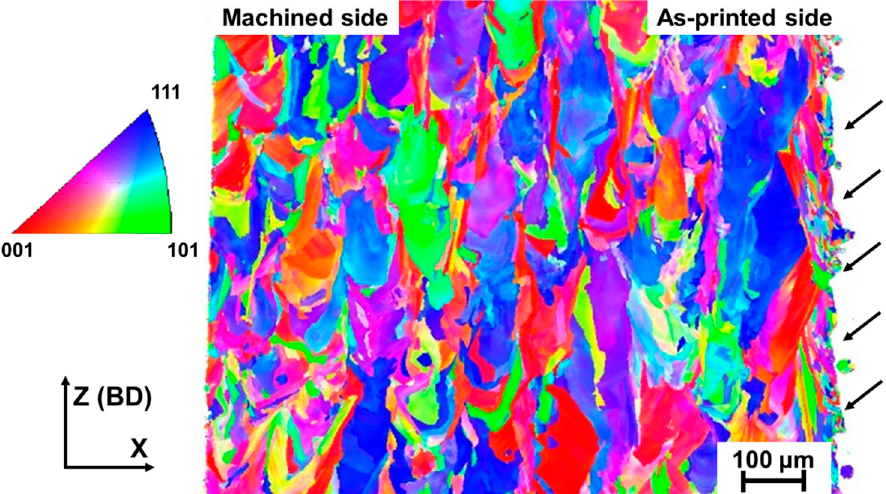
Figure 9. EBSD maps of similar sample as Figure 7 where a randomized texture is formed on the as-printed side. A possible reason could be due to re-melting caused by contour scanning.